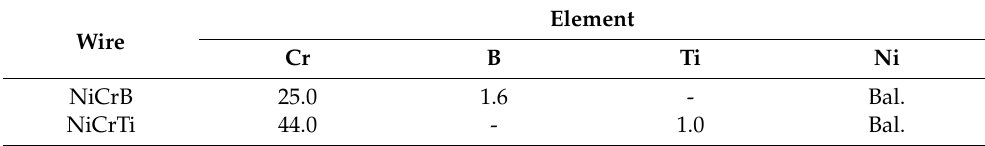
Table 1. Nominal chemical compositions of NiCrB and NiCrTi wires in mass content. Element Wire Cr B Ti Ni NiCrB 25.0 1.6 - NiCrTi 44.0 -